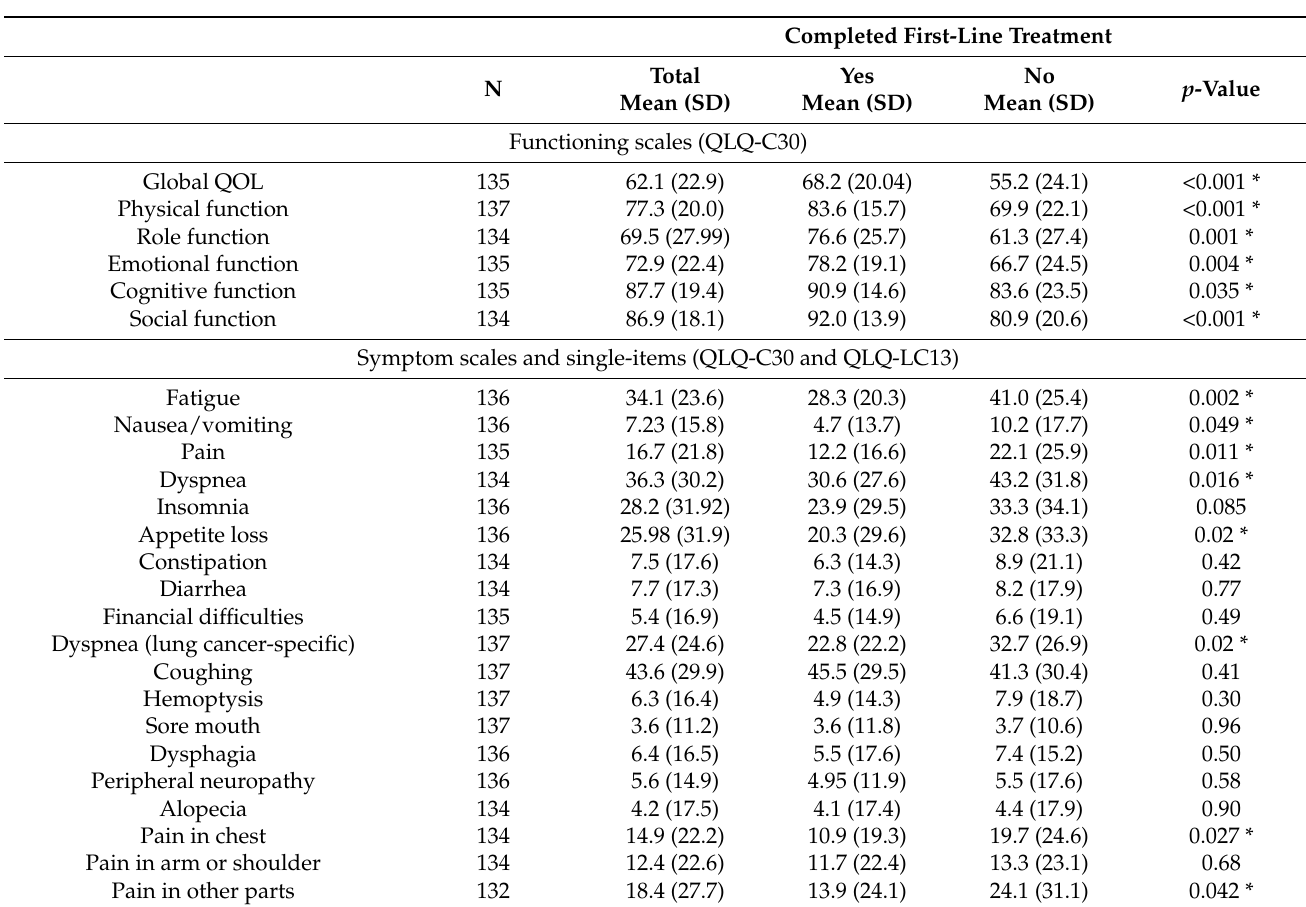
Table 2. Pretreatment quality of life and symptom burden by completion of first-line treatment in 137 newly referred patients with lung cancer, Herlev University Hospital, Denmark,